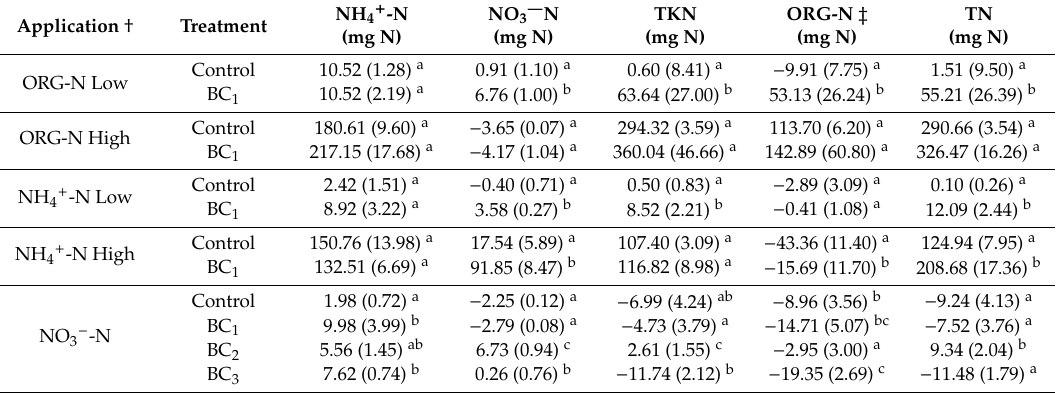
Table 2. Change † in soil N for ORG-N low (treatment group 1), ORG-N high (treatment group 2), NH 4 + -N low (treatment group 3), NH 4 + -N high (treatment group 4) and NO 3 − -N (treatment group 5) after 10 weeks of nutrient application. Values are means (standard deviation) of triplicates. Di ff erent letters represent significant di ff erence ( p = 0.05) between soil N within application